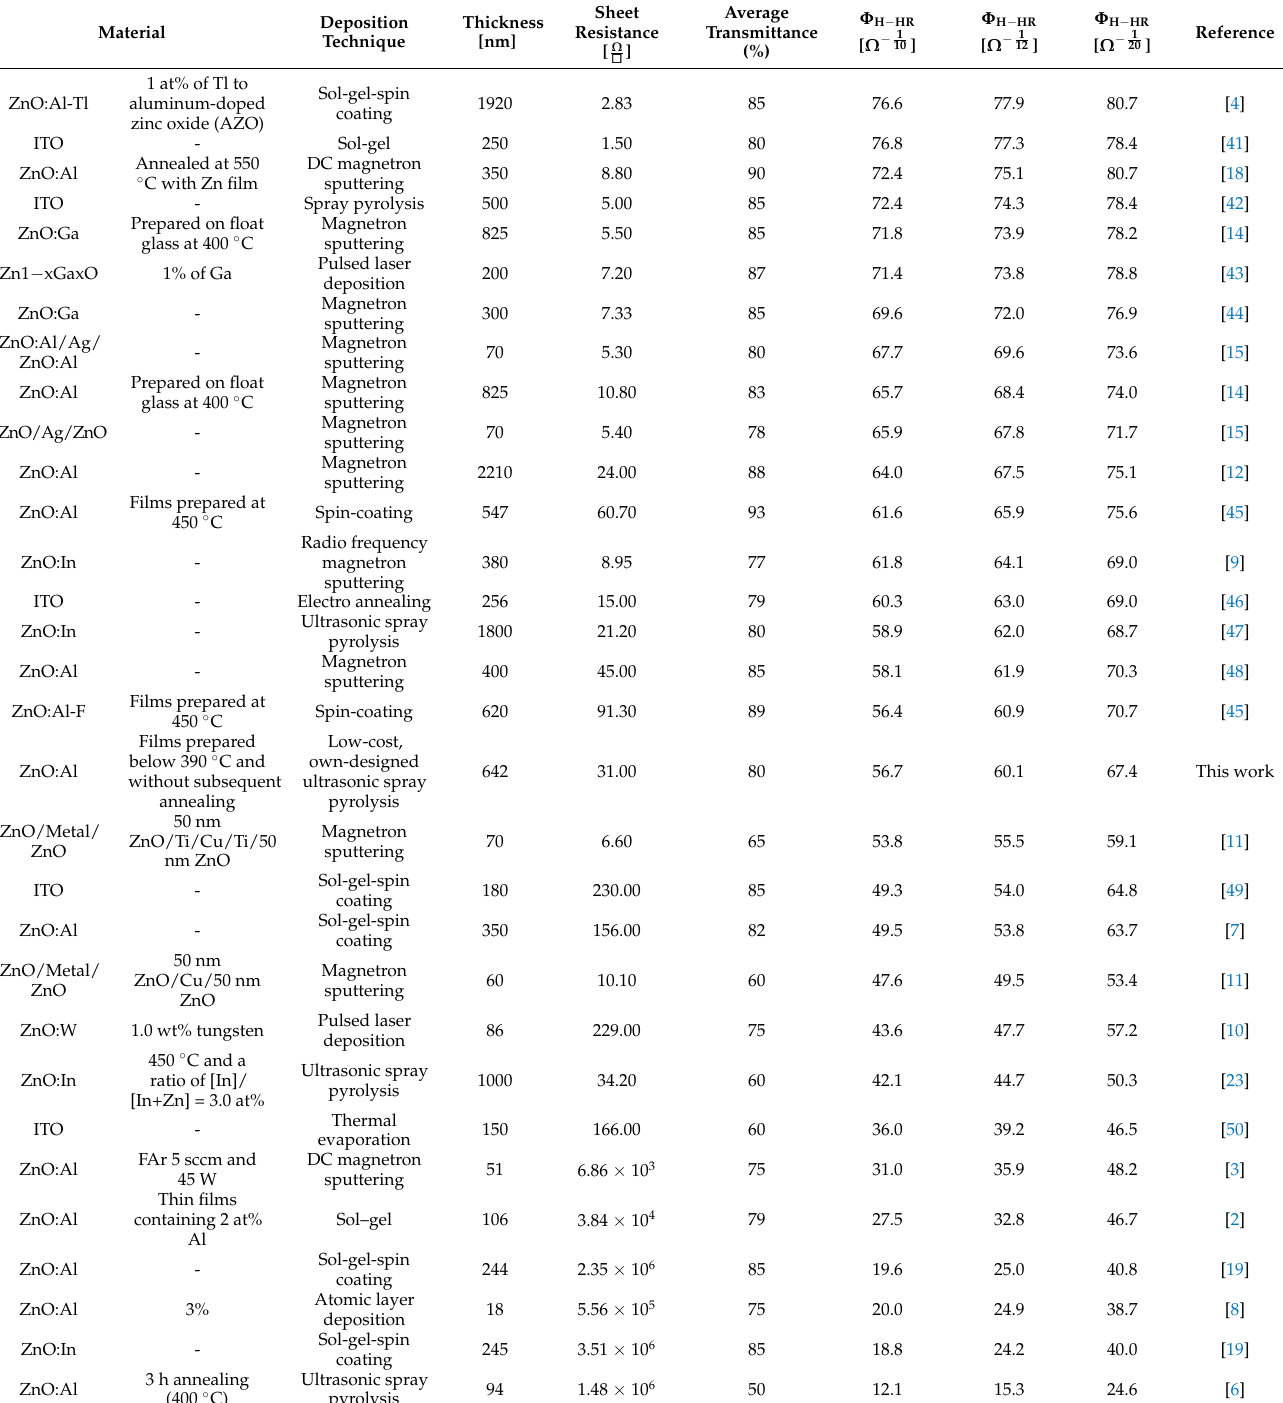
Table 2. Comparison between our depositions and thirty of the most referred TCOs deposited through different deposition